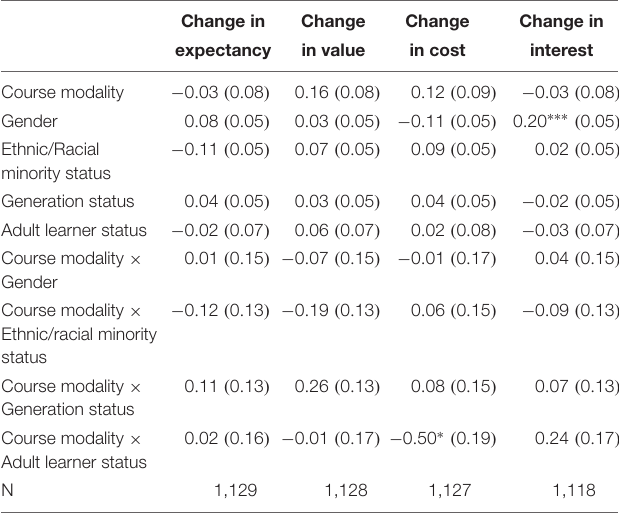
TABLE 3 | Course modality and demographics predicting change in motivation (Weeks